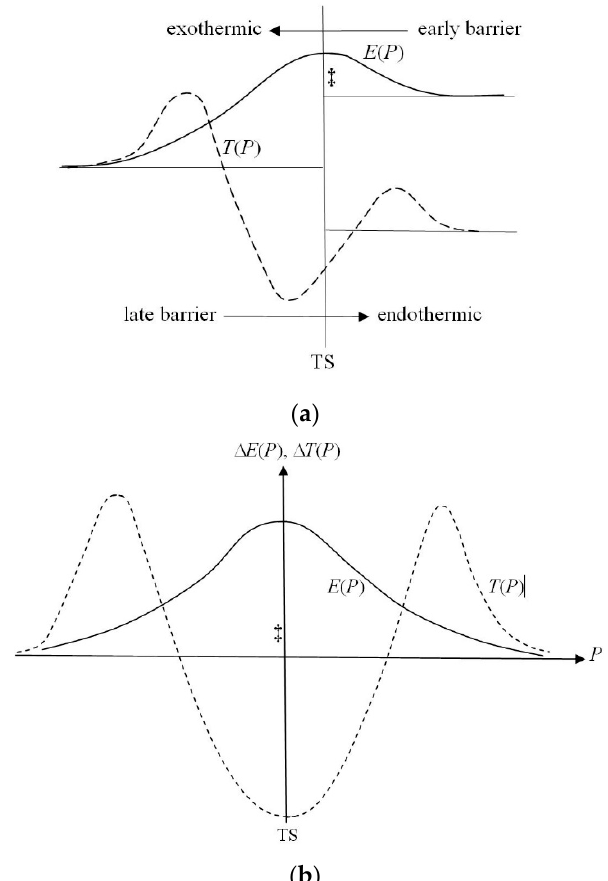
Figure 3. Variations of the electronic total ( E ) and kinetic ( T ) energies in exo-ergic ( Δ E r < 0) or endo- ergic ( Δ E r > 0) reactions (upper Panel ( a )), and on the symmetrical BO potential energy surface (PES) ( Δ E r = 0) (lower Panel ( b )).